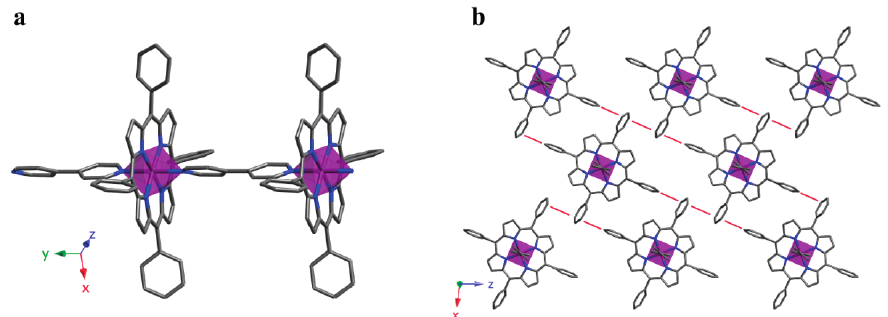
Figure 7. ( a ) 1D coordination polymers extending along the [010] direction and ( b ) view of a (101) plane for compound 3 . (Fe: purple, C: grey, N: dark blue). π - π interactions are marked as red lines. H atoms have been omitted for clarity.